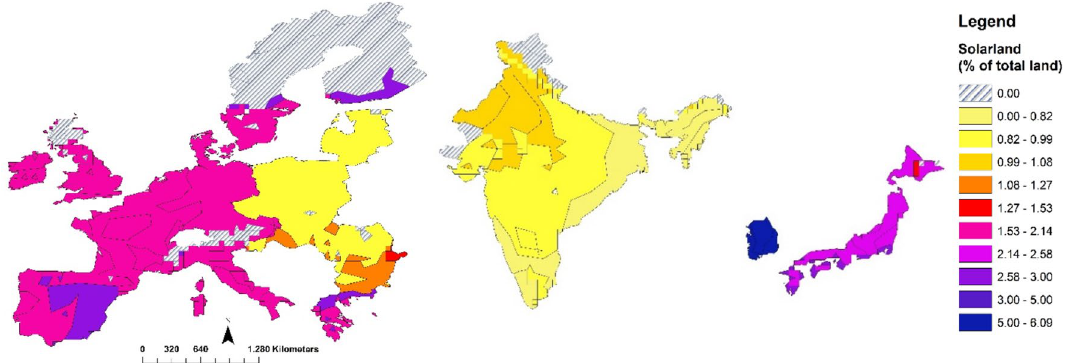
Figure 1. Geographical distribution of the share of total land occupied by solar energy within each region, by agro-ecological zone. See “Methods” section and Figure S1 of the SM for more information on the spatial resolution used in this study. Source: Authors´ own elaboration with the Arc GIS 10.5.1 Desktop (Esri)